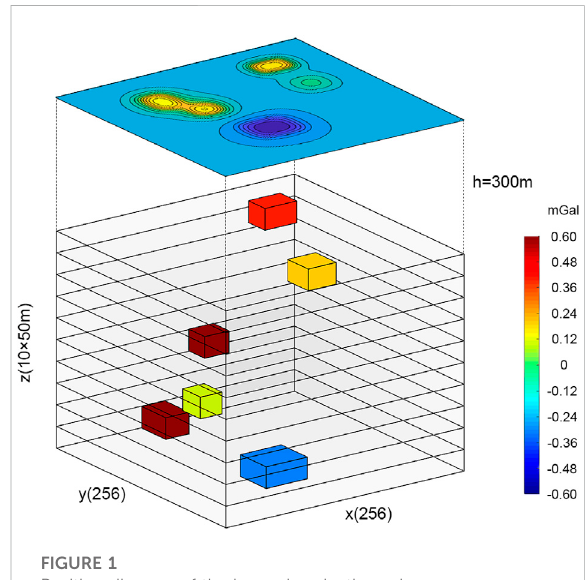
FIGURE 1 Position diagram of the layered projection